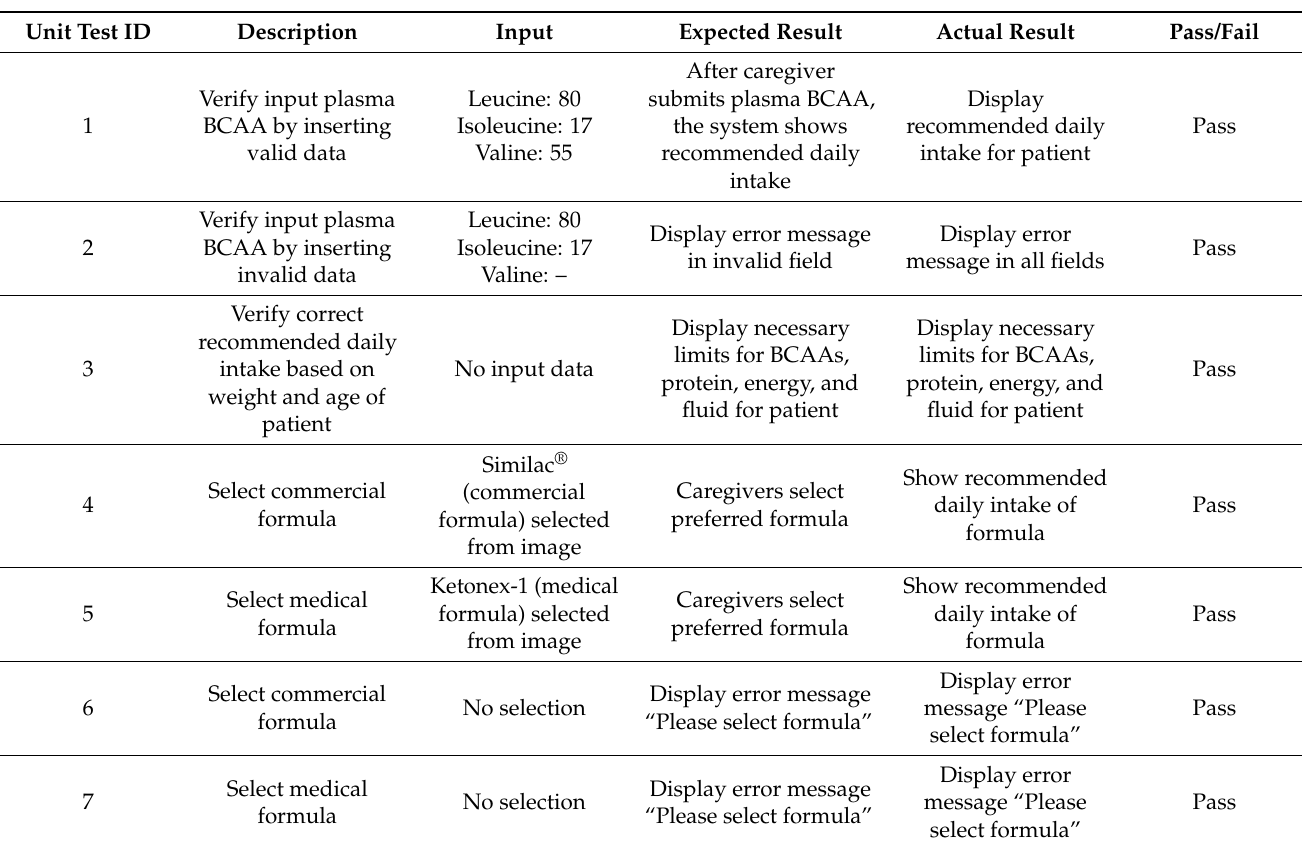
Table 3. Unit testing for three functions of MSUD Baby